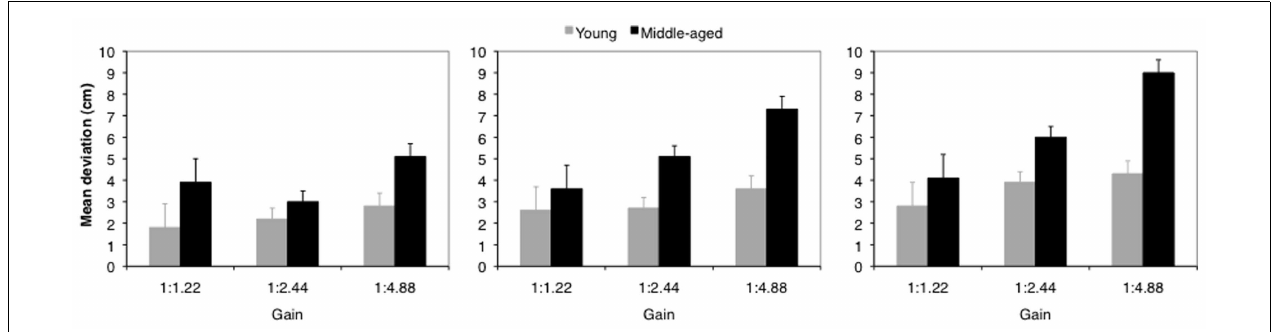
FIGURE 1 | Mean deviation (cm) between pre-determined hand amplitude and estimated hand amplitude for a pre-determined hand amplitude of 20mm (left), 40mm (middle), and 60mm (right). Error bars represent the standard error of the